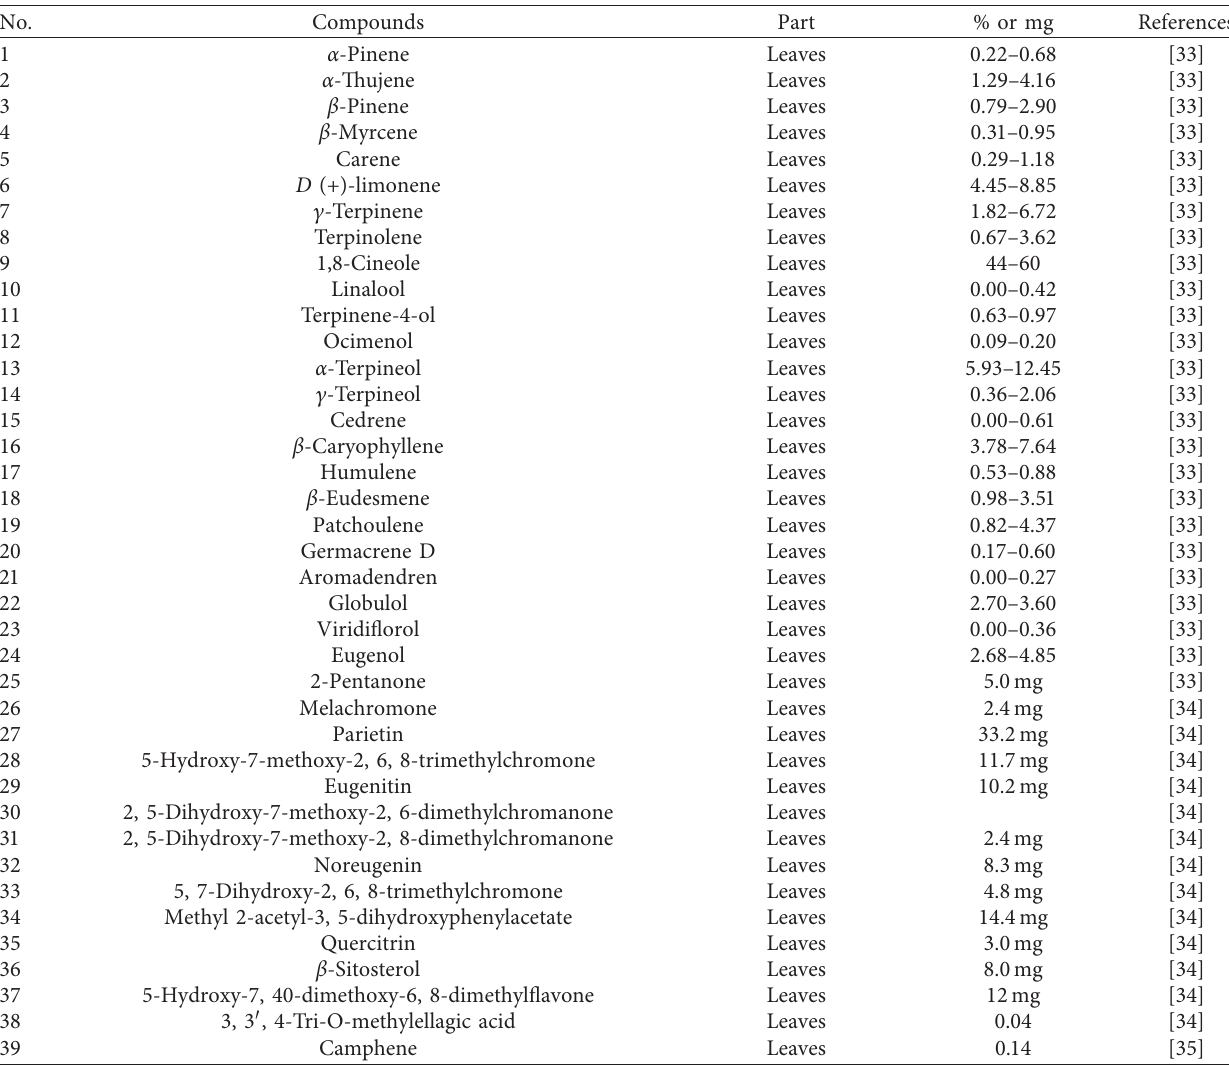
Table 1: Identification and quantification of the compounds in cajuput ( Melaleuca leucadendron ) (reported in 2011–2020).